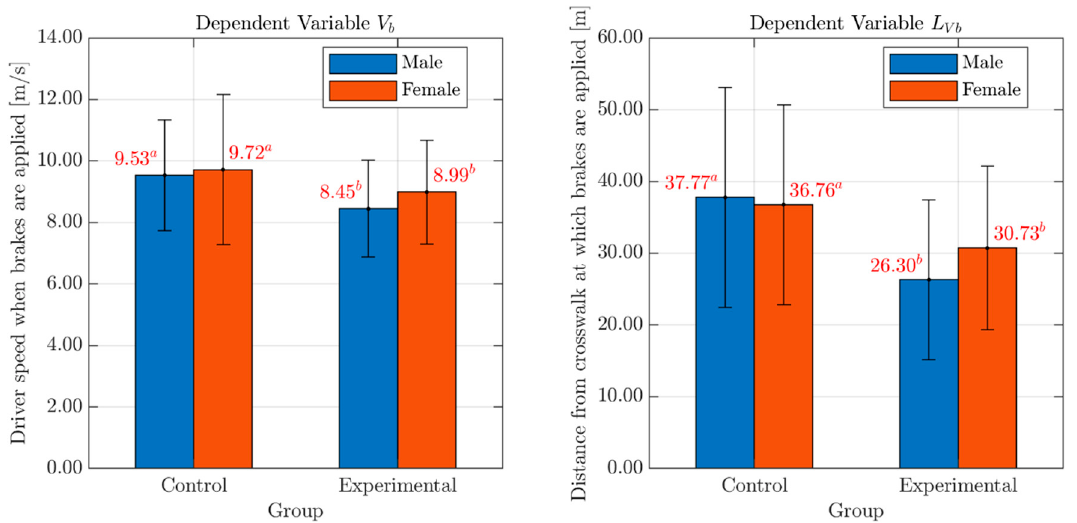
Figure 6. E ff ects of Gender and Group on the variables V b and L Vb . Legend : Red numbers above the Figure 6. Effects of Gender and Group on the variables (cid:1848) (cid:3029) and (cid:1838) (cid:3023)(cid:3029) . Legend : Red numbers above the bars represent mean values of the variables V b and L Vb , for males (blue bar) and females (red bar) in bars represent mean values of the variables (cid:1848) (cid:3029) and (cid:1838) (cid:3023)(cid:3029) , for males (blue bar) and females (red bar) in each Group. Statistically significant di ff erences are indicated by di ff erent superscript letters. Standard each Group. Statistically significant differences are indicated by different superscript letters. Standard deviation error bars are also reported for each deviation error bars are also reported for each sub-group.